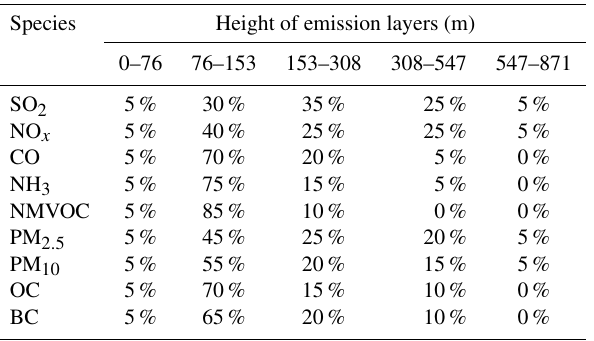
Table 2. Vertical distributions of power plant emissions: percentage of each species allocated to the height of the vertical layers in the WRF-Chem